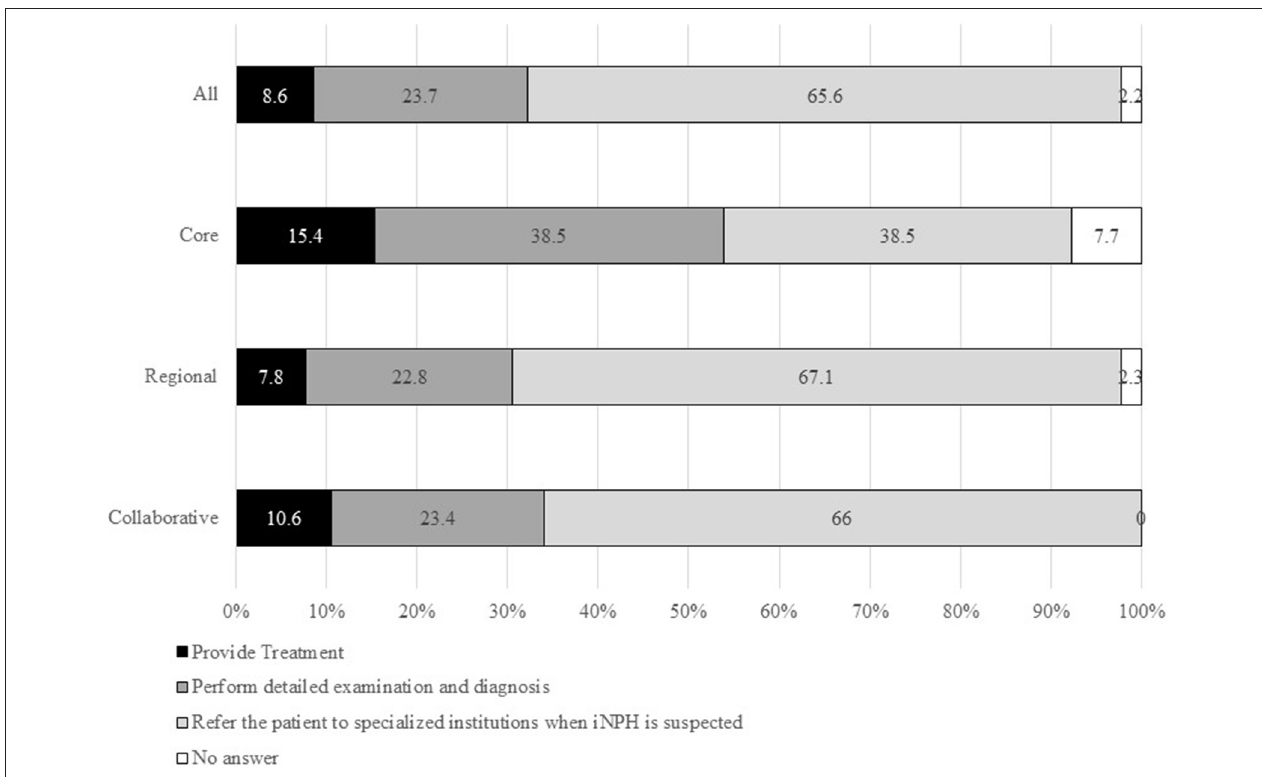
FIGURE 6 | Percentages of “Yes” in answer to “To what extent do you think MCDs should evaluate and treat patients with cognitive impairment due to suspected iNPH?”.